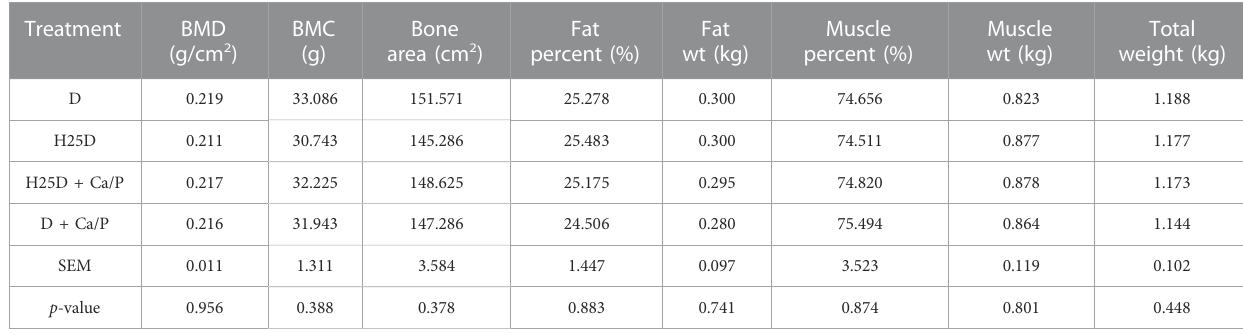
TABLE 5 DEXA results for week 17.